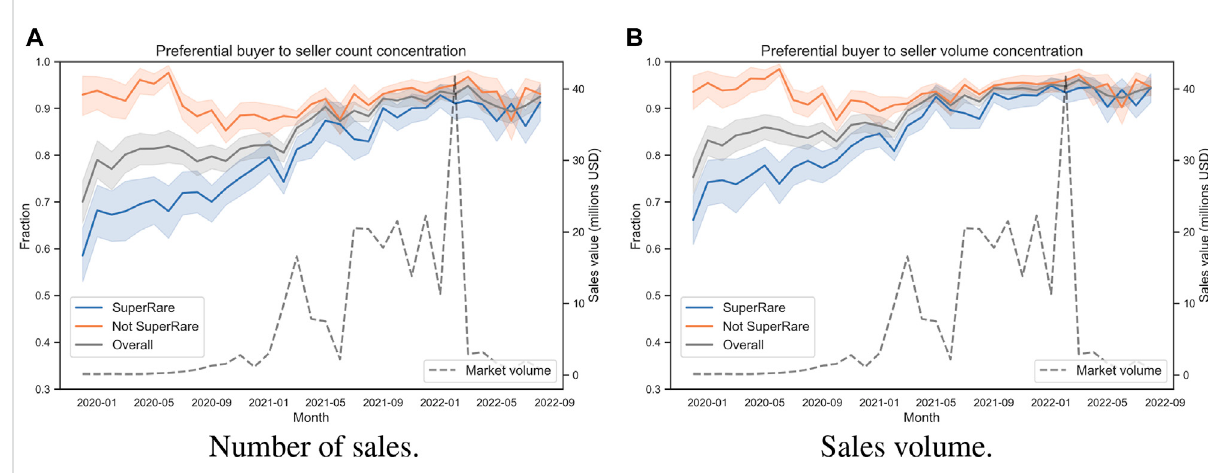
sorted on the x axis, while the fraction of sales they control is cumulatively given on the y axis. Black dotted lines can be used to fi nd the 10% – 90% and 20% – 80% intersections.